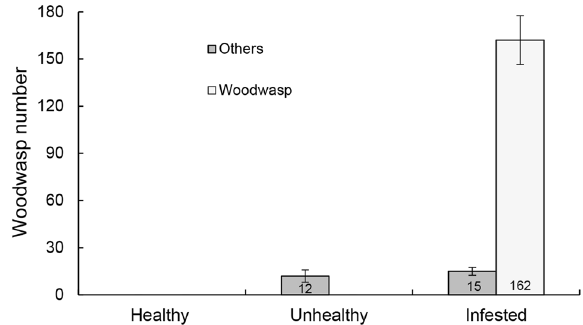
Figure 1. The number of S. noctilio and other species of woodboring insects in different sampled trees. Bars and brackets are means and standard error, respectively. Numbers inside the bottoms of the bars are the number of S. noctilio or other borers. Healthy Healthy uninfested trees, Unhealthy Unhealthy uninfested trees, Infested S. noctilio infested trees.